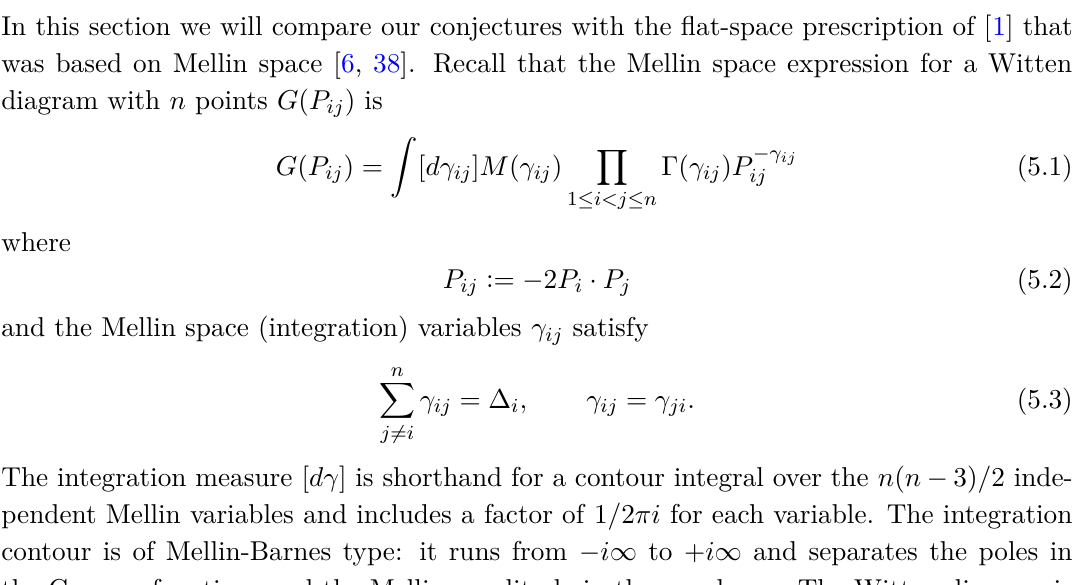
Figure 14. Left: regions in the complex s plane (shaded) where the AdS Landau diagram domi- nates over the flat-space saddle point. We have set m = 1 . The dots, lines and crosses are flat-space data: they are respectively the start of the anomalous threshold at 4 m 2 − m 4 /µ 2 , the branch cuts emanating from it, and the physical threshold 4 µ 2 which is a little further along the cut. (The anomalous and physical threshold coincide when µ/m = regions obtained numerically. Note that they always lie within the disk given by | s − 4 m 2 | < 4 m 2 whose boundary is the black dashed circle. Right: the red dots indicate, for a given µ ∈ the smallest real s for which the AdS Landau diagram dominates. They are in perfect agreement with the yellow curve which is the flat-space anomalous threshold. The physical threshold is in- dicated by the purple curve. The blue curve will be useful later for discussion in section 5. The vertical lines correspond to the branch cuts for different µ as in the left